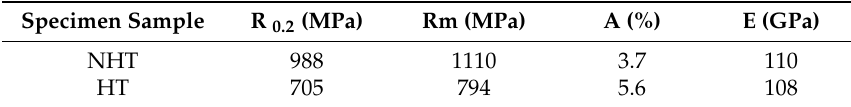
Figure 11. An example of stretching curves for samples cut from the Ti6Al4V thin walls obtained using the LENS technique without (NHT) and with (HT) additional heat treatment process [56]. Table 4. Strength parameters determined in a tensile test for samples cut from Ti6Al4V thin walls obtained by the LENS technique (before and after the heat treatment process).